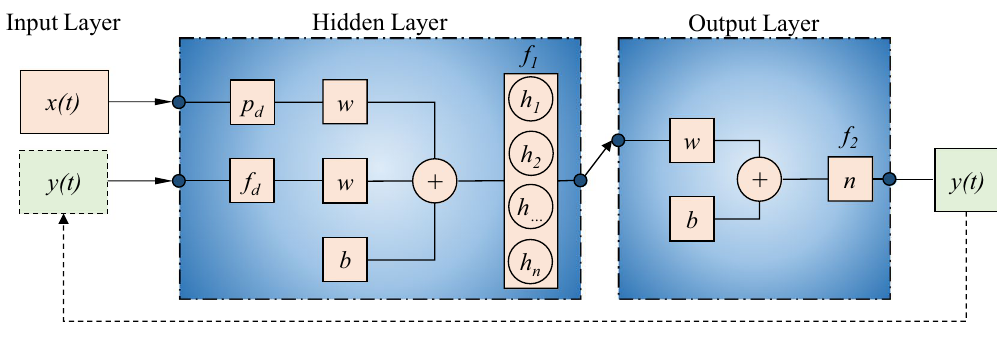
Figure 3. Sketch of the NARX architecture.